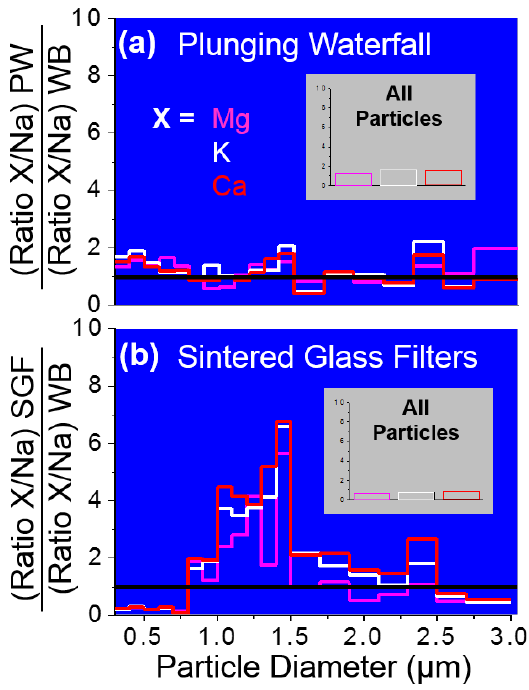
Figure 4. Elemental composition of particles produced via (a) Figure 4 : Elemental composition of particles produced via (a.) plunging waterfall (PW) and 4 plunging waterfall (PW) and (b) sintered glass filters (SGF), com- (b.) sintered glass filters (SGF), compared to particles produced via wave breaking (WB). The 5 pared to particles produced via wave breaking (WB). The compari- son is made using the ratio of the EDX intensities (counts per sec- comparison is made using the ratio of the EDX intensities (counts per second) for Mg, K, and 6 ond) for Mg, K, and Ca referenced to Na in SSA particles. Devia- Ca referenced to Na in SSA particles. Deviation from unity indicates differences in chemical 7 tion from unity indicates differences in chemical composition. The composition. The number of particles in each size bin can be found in Table 1. 8 number of particles in each size bin can be found in Table